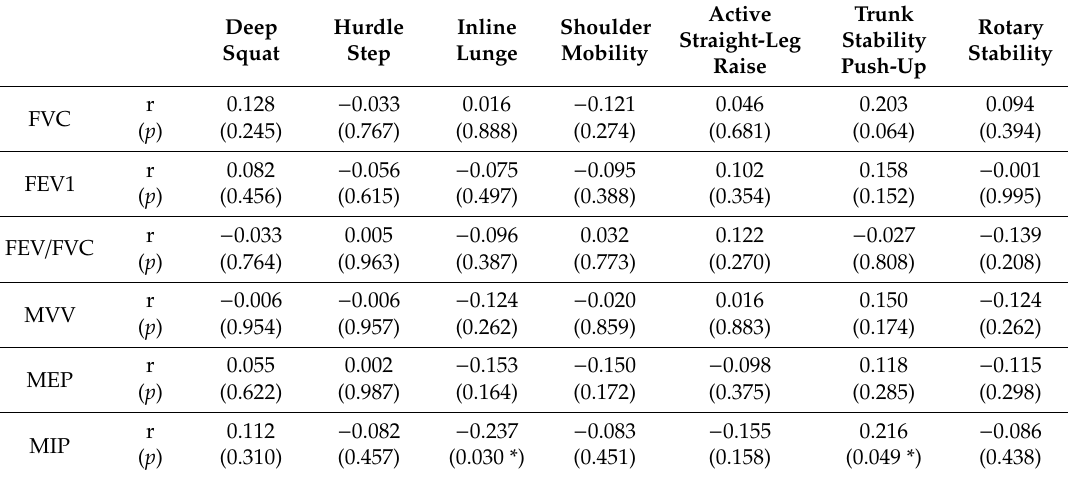
Table 7. Correlation between lung function variables and functional movement screen scores in male participants.